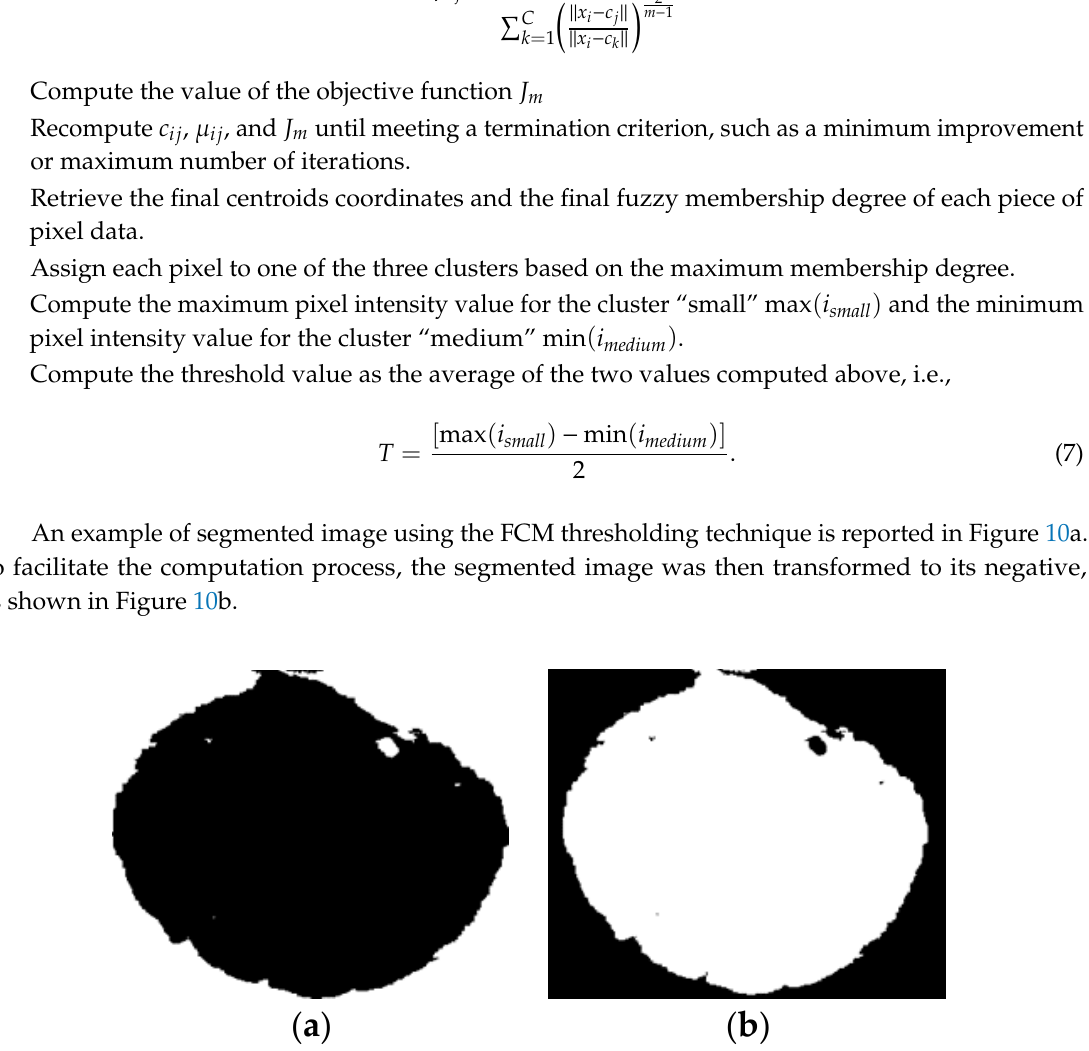
Figure 10. Image segmentation steps: Fuzzy c-means (FCM) segmented image ( a ), negative ( b ). From the negative segmented image, the surface fouling is computed as the sum of the pixel intensities, i p , as reported in Equation (8), where m and n are the horizontal and vertical image resolution,